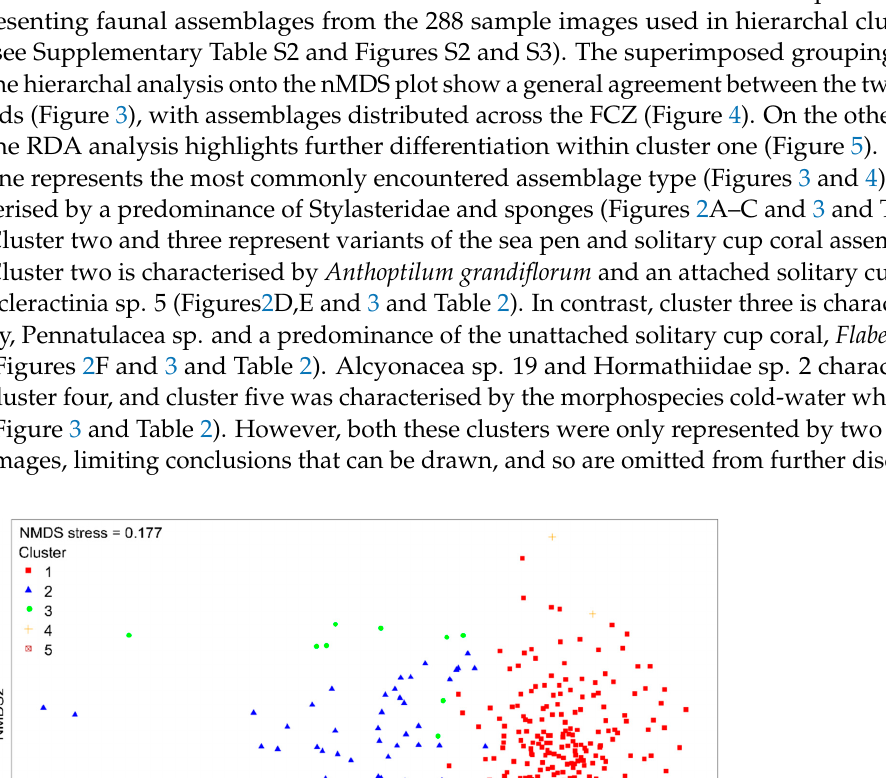
Figure 2. Example images of fauna and substrata. ( A ) Bathelia candida reef observed at 1280 m water depth. ( B ) Mixed cold-water corals, including Stylaster densicaulis and Primnoidae, Stylasteridae, and Porifera morphospecies observed at 1280 m water depth. ( C ) Stylasteridae and Massive Ball Porifera morphospecies were observed from mixed substratum at 1595 m water depth . ( D ) Solitary cup corals, including Flabellum sp. and Scleractinia sp. 5, were observed from coarse substratum at 1406 m water depth. ( E ) Anthoptilum grandiflorum and Flabellum sp. observed from sandy mud at 1225 m water depth. ( F ) Pennatulacea sp. and Flabellum sp. observed from sandy mud at 1330 m water depth. Scale bar = 30 cm.